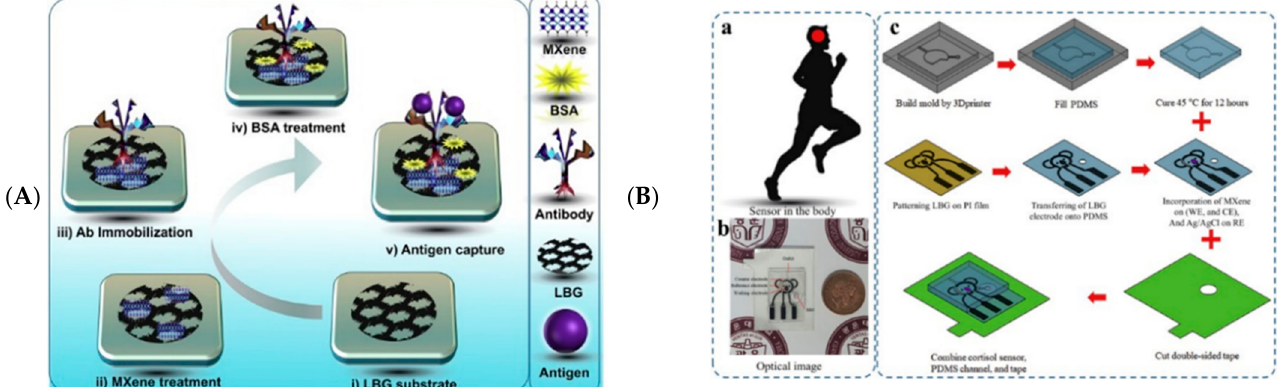
Figure 13. (A) Schematic representation of the Ti 3 C 2 Tx MXene-loaded/LBG-based cortisol biomarker assay. (B) Patch sensor attached to the body position (a), optical image of the wearable patch (b) and fabrication sequence of a wearable patch cortisol sensor integrated with a microfluidic system (c). Reprinted with permission from Ref. [132]. Copyright 2020, Elsevier.